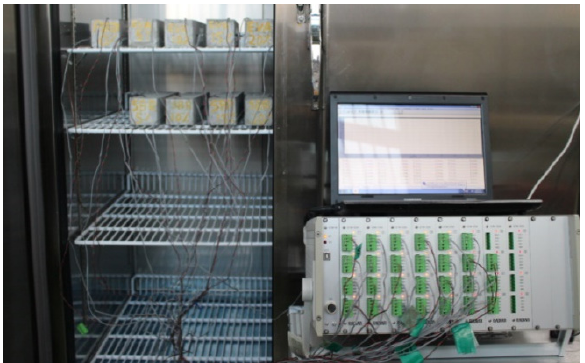
Figure 3. Test setup for measuring thermal expansion.